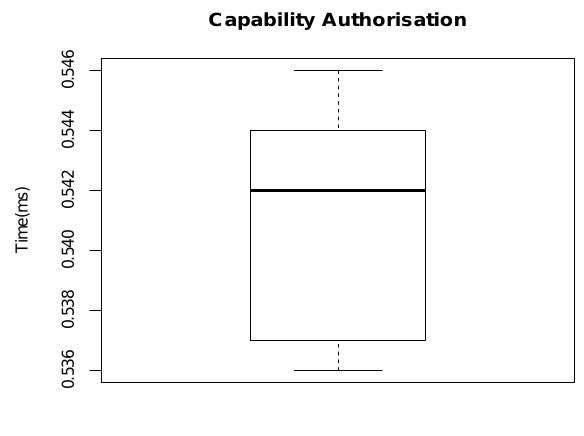
Figure 8. The capability authorisation time for an invalid capability.Inthis case the timestamp(ts) is notvalid,therefore, the capability is rejected at the very firs instance without checkingthe otherfields section 8.2, including both when access is allowed and when it is denied and involving the TH checking a vary- ing number of conditions. In order to demonstrate the feasibility of our model, each test was run 100 times to ensure reliable data. To demonstrate the time taken by our proposal, all considerations which are extraneous are excluded, e.g. delays due to other network tra ffi c. This allows us to demonstrate the load/delay created by our proposal. For every success and fail, an appropriate message (e.g. allowed or denied) is sent to the UD.